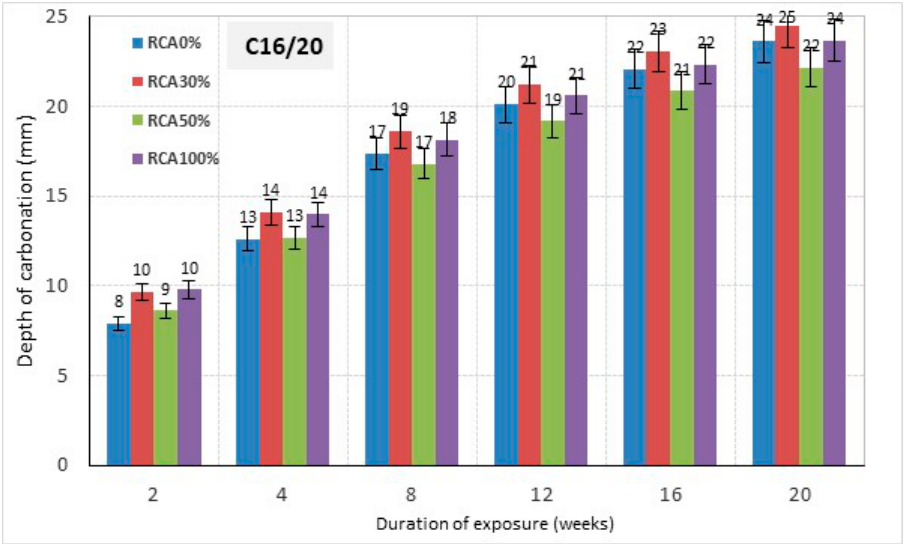
Figure 15. Depth of carbonation versus the exposure duration of C16/20 concretes. Buildings 2020 , 10 , x FOR PEER REVIEW